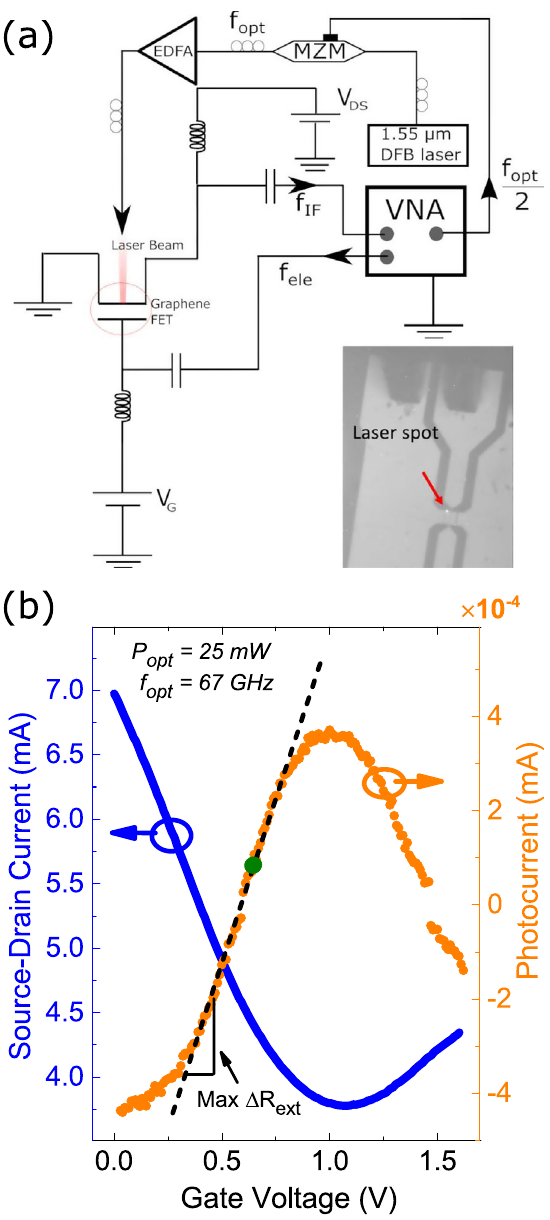
Fig. 2 Measurement setup and device characteristics. a Experimental setup: a CW laser is modulated via a MZM. It is then ampli fi ed with an EDFA and focused on the GFET. An AC signal is applied to the gate. The output f IF is measured on a VNA. Inset: optical image of device with laser focused on the channel. b Blue curve: source-drain current versus gate voltage, for V DS = 200 mV. Orange curve: photocurrent versus gate voltage, generated by a 25 mW beam focused on the SLG